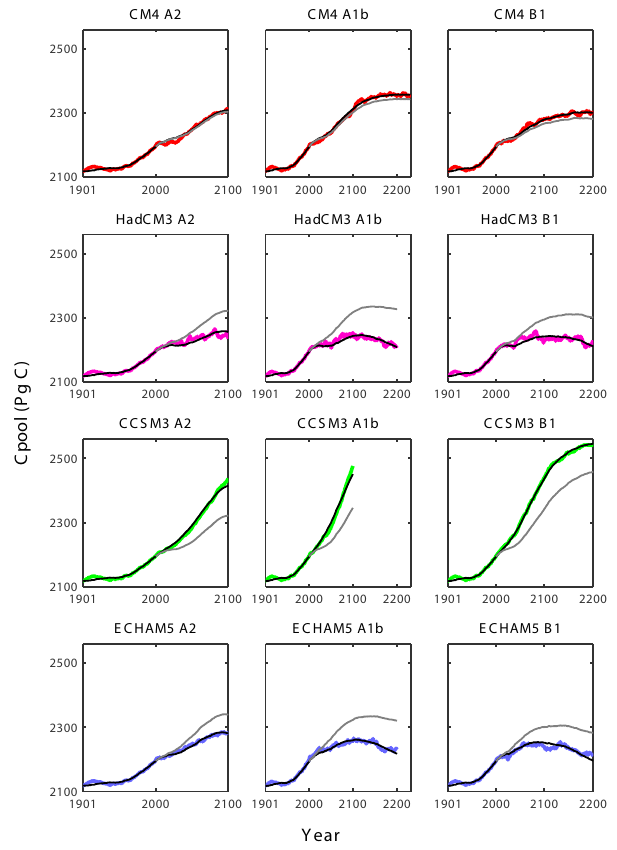
Fig. 3. Global terrestrial ecosystem carbon pool (Cpool) as simu- lated by LPJ-GUESS (colours) and the dynamic replacement model with average α (grey) or simulation-specific fit for α (black).